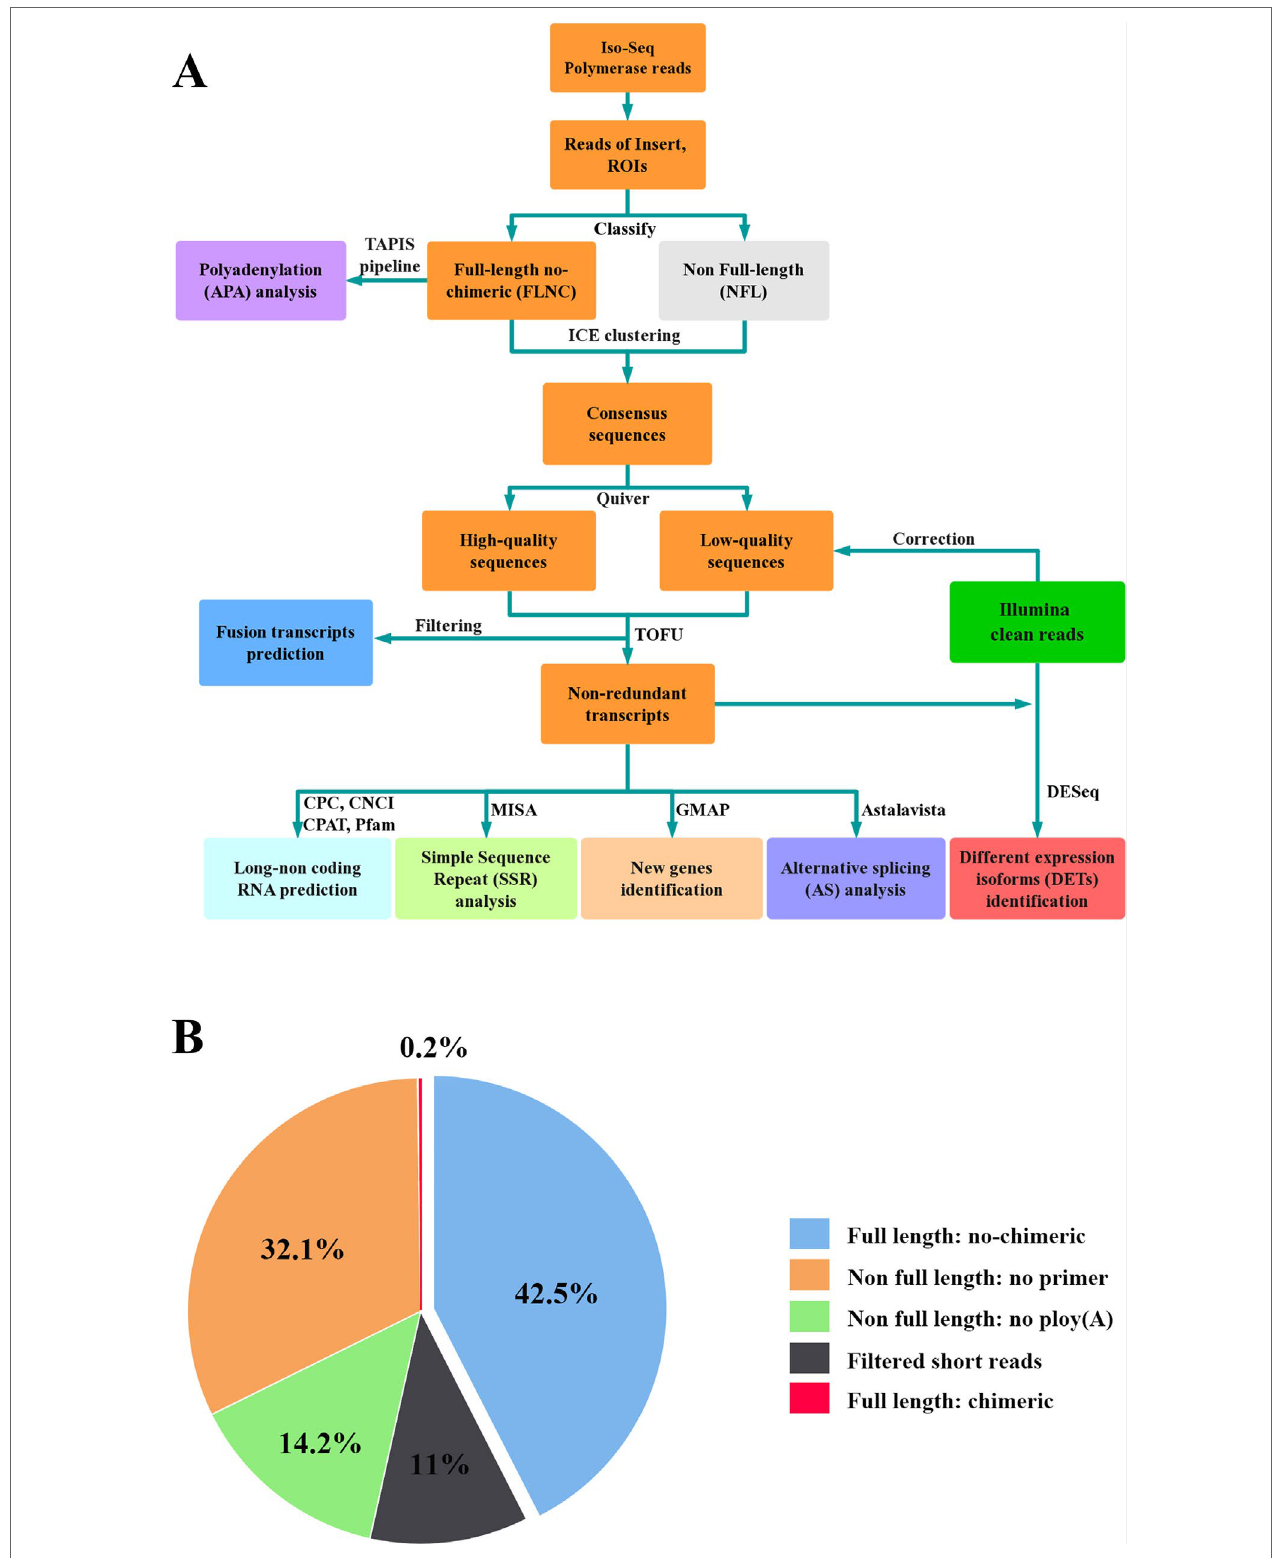
FIgURe 1 | Iso-Seq analysis pipeline and ROIs classification. (a) Pipeline of bioinformatic analysis in Iso-Seq. (B) Pie chart of ROIs classification for Iso-Seq. Full- length reads: containing 5’ primer, 3’ primer and the poly (a) tails. Filtered short reads: length 300 bp; Chimeric reads: containing artificial concatemers.